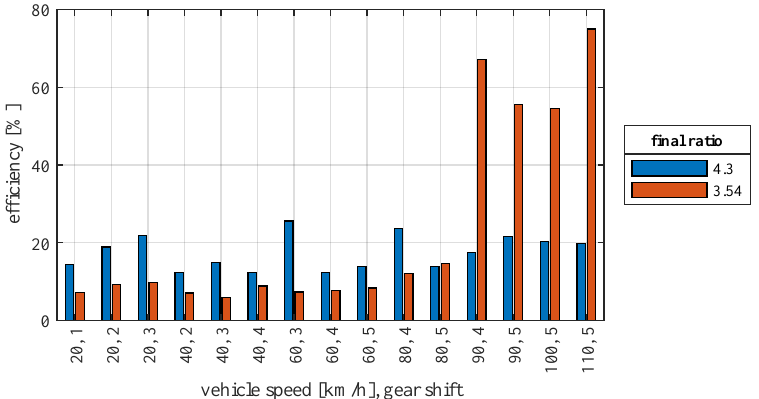
Figure 15. Efficiency at a constant